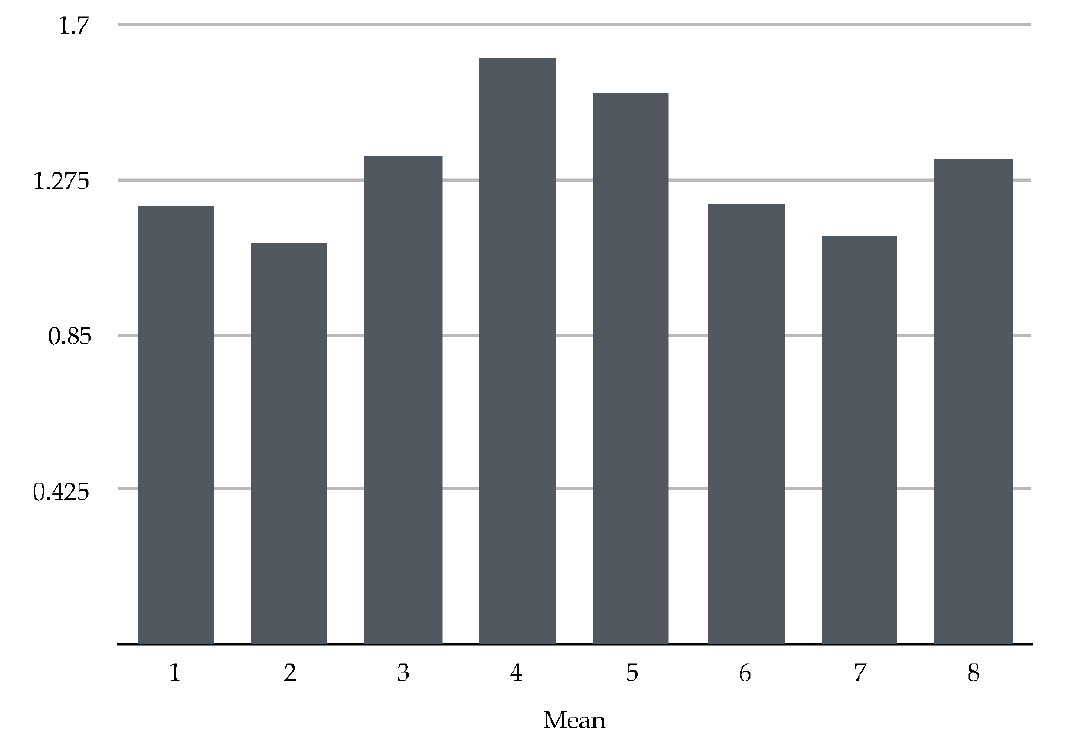
Figure 2 . Attitude towards